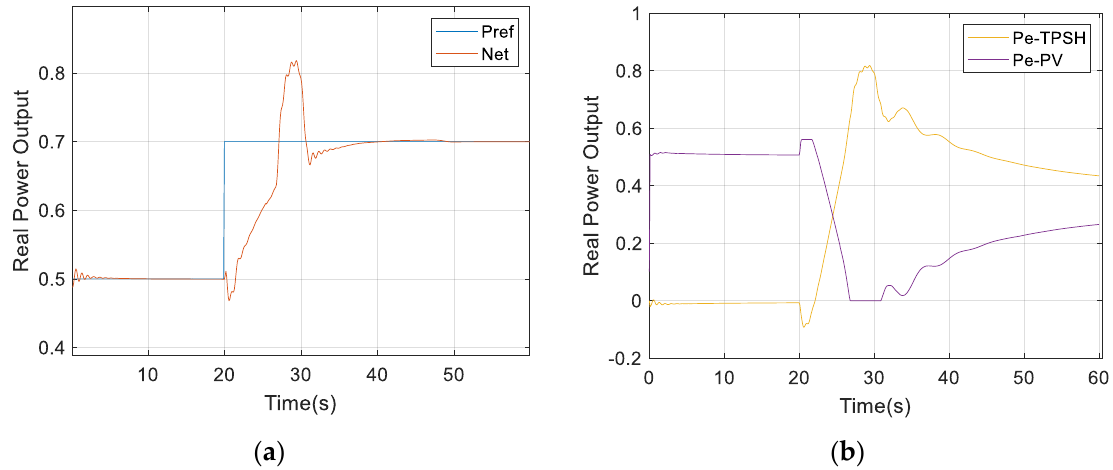
Figure 12. Transition firming showing ( a ) net response of the hybrid plant and ( b ) power output from PV and TPSH during dynamic simulation to meet set-point.